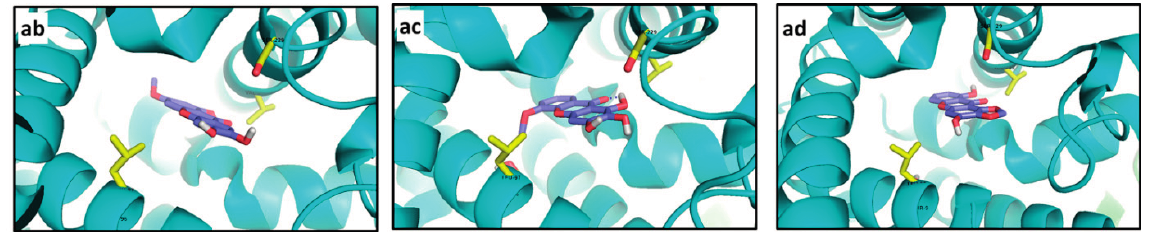
Figure 15. Best docked poses for tested xanthones. ( a ) 266 —R1; ( b ) 214 —R1; ( c ) 1